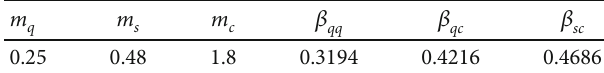
Table 1: The constituent quark mass (GeV) and the Gaussian parameters β (GeV) for the HO potential obtained by the variational principle [49, 57]. q = u and d